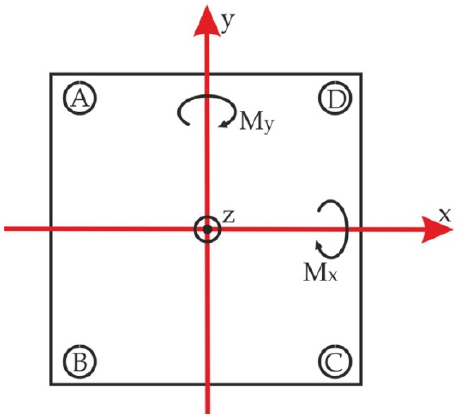
Figure 1. Scheme of the instrumented chair load plane: The reference system for the dynamic components are identified by (x,y,z) axes, while the load cells positions are identified by the {A,B,C,D} markers.